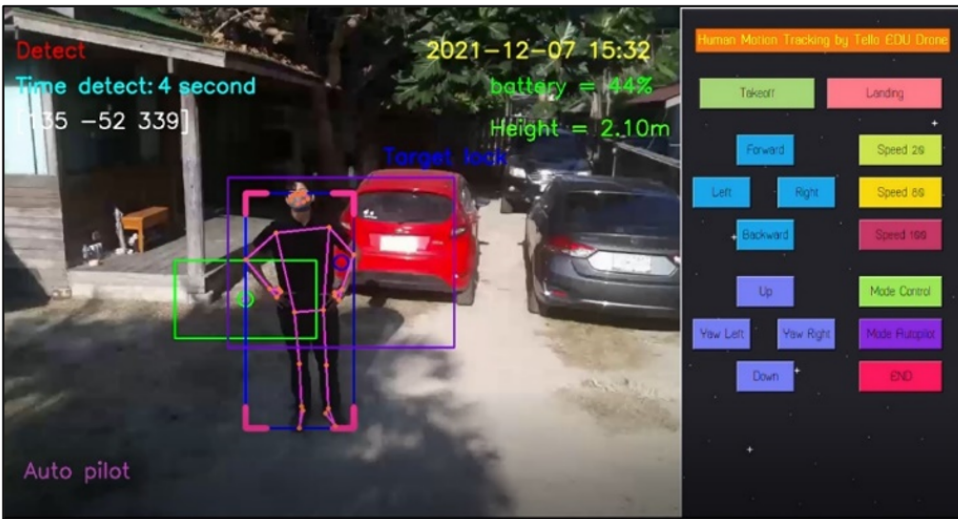
Figure 25. Display including control panel and first picture saved in a created folder.